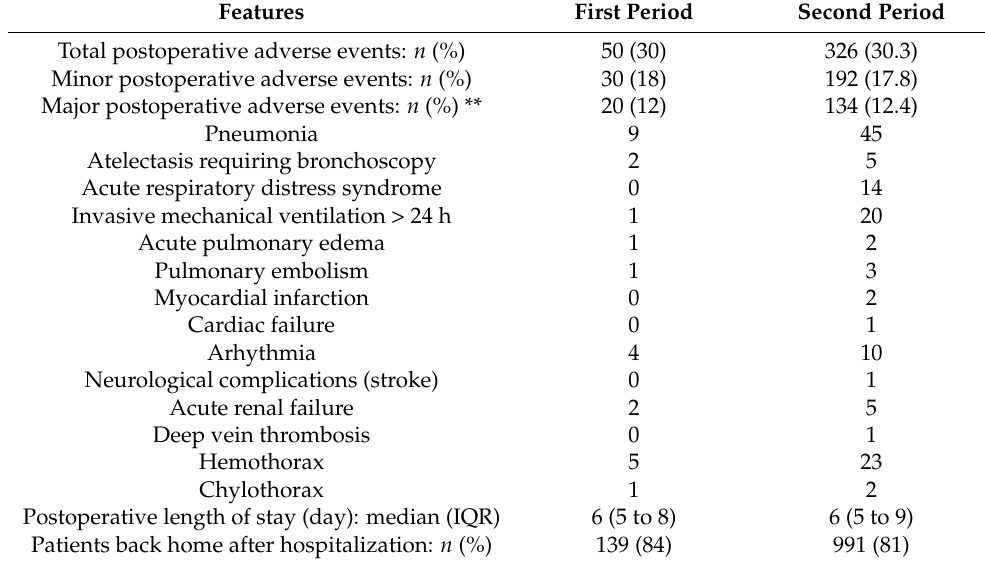
Table 3. Patient